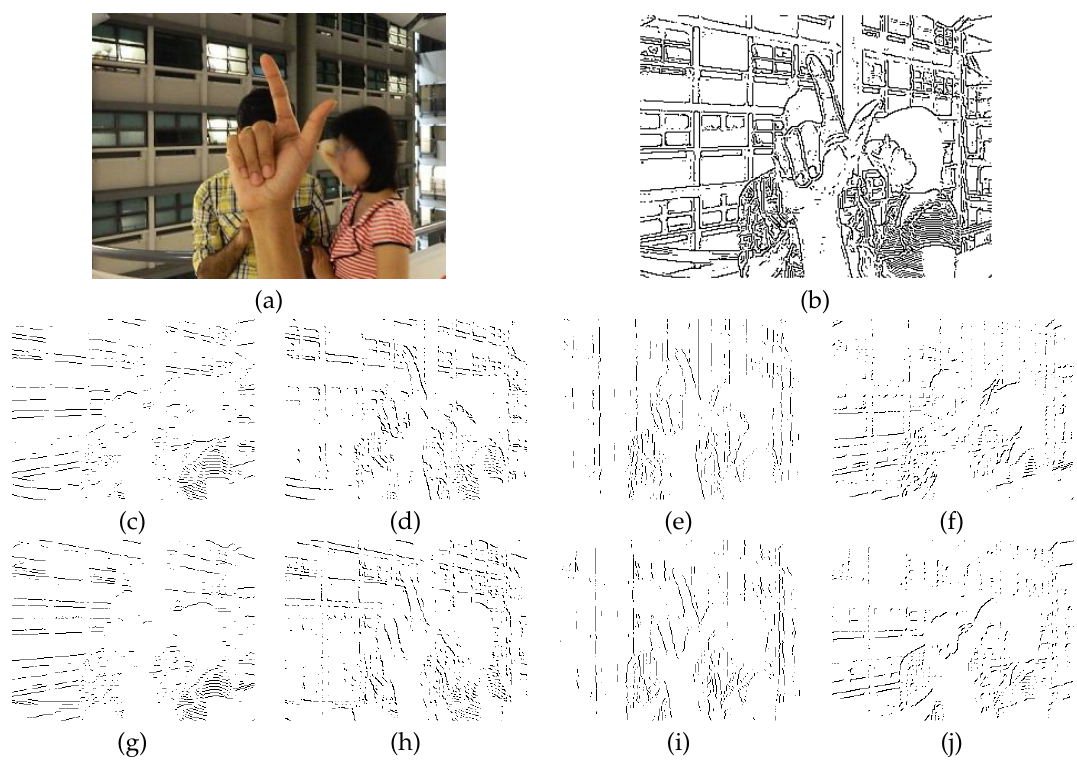
Figure 3. Edge maps for eight orientations: ( a ) input image taken from the NUS-II image dataset and ( b ) edges calculated from the input image. Integral images are computed from this edge map. Their rotated versions are used to compute the pose-indexed